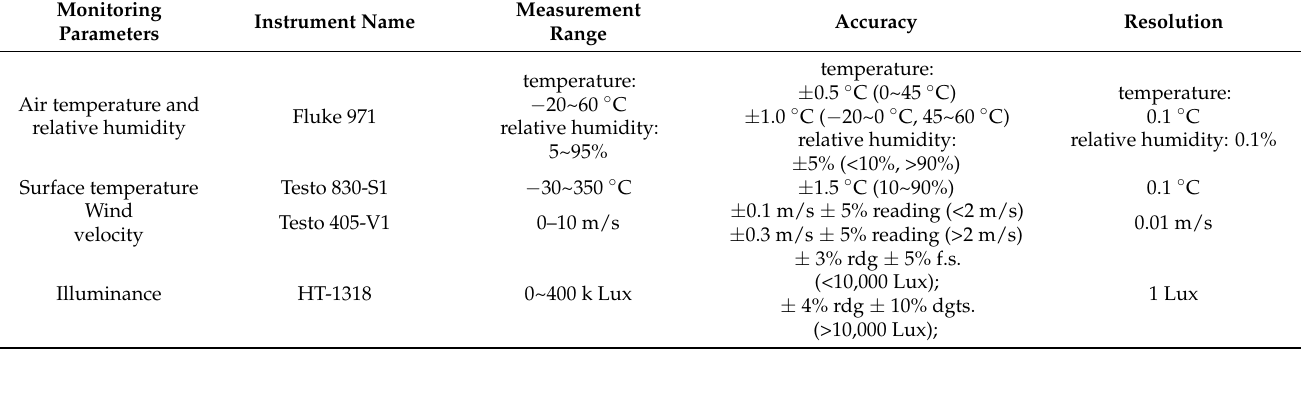
Table 4. Monitored data and technical specifications of measuring instruments.